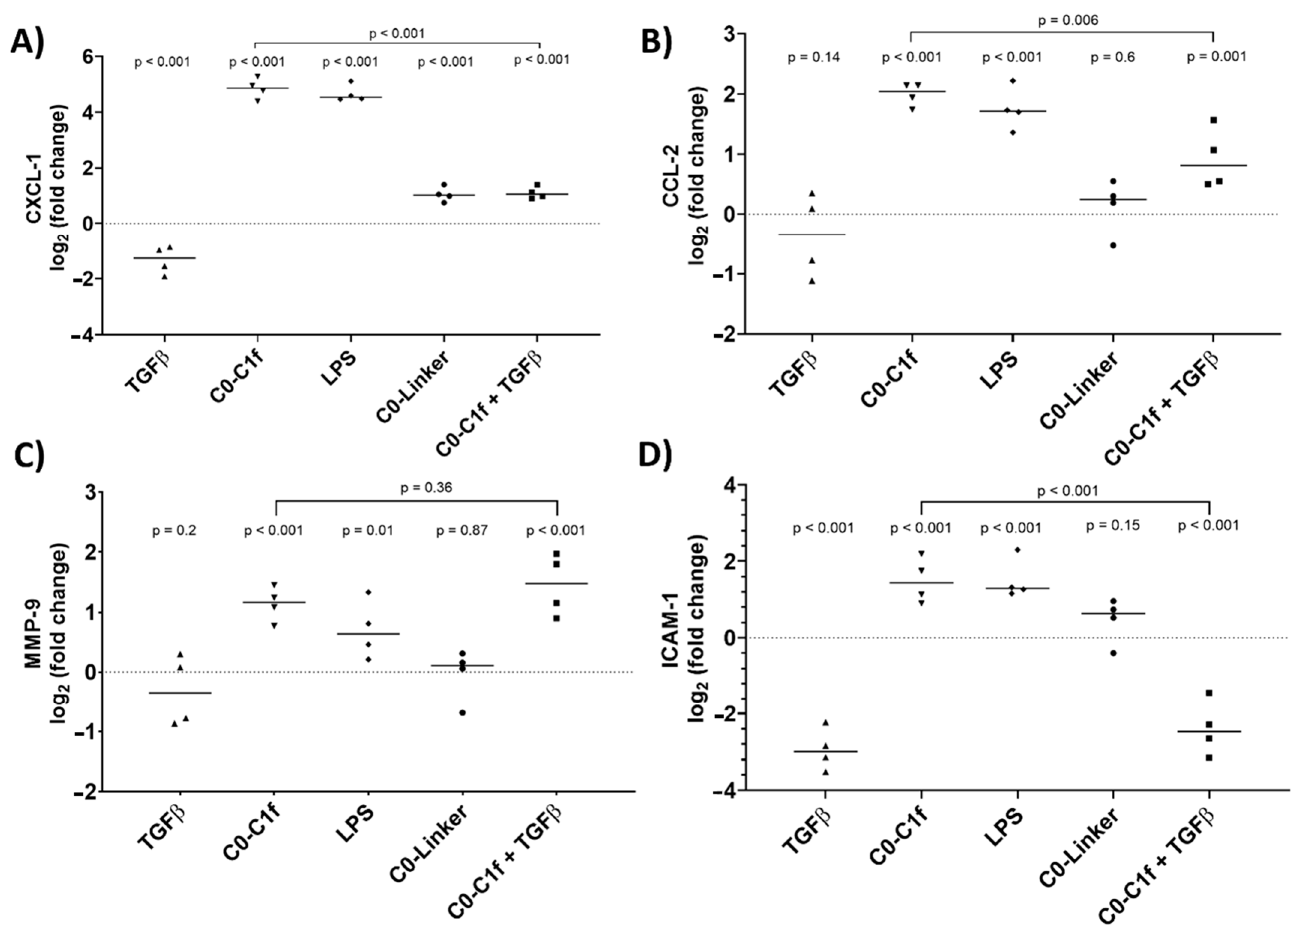
Figure 3. Activation of fibroblasts. huFib cells were treated with 1 µg/mL LPS, 500 ng/mL C0-Linker, or 500 ng/mL C0-C1f and/or 10 ng/mL TGF β . ( A ) CXCL-1 ( B ) CCL-2 ( C ) MMP-9, and ( D ) ICAM-1 mRNA abundance was detected by qPCR after 24 h treatment. Data are displayed as individual data points and means; p -values above each condition refer to differences between means (horizontal lines) and 0 fold change (unstimulated controls) unless otherwise indicated. ( n = 4; n represents biological replicates).